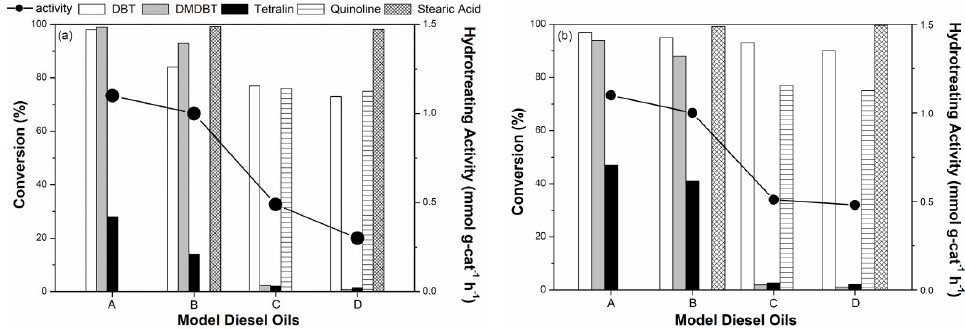
Figure 6. The catalytic activities of the mesoporous sulfide catalysts ( a ) CoMo/γ-Al 2 O 3 and ( b ) NiMo/γ-Al 2 O 3 in the hydrotreating of model diesel oils A–D at 330 ◦ C and 1 h under a pressurized atmosphere of H 2 (5 MPa).